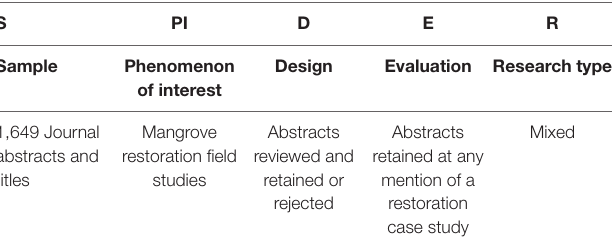
TABLE 2 | Spider protocol applied for abstract inclusion/exclusion (Cooke et al.,